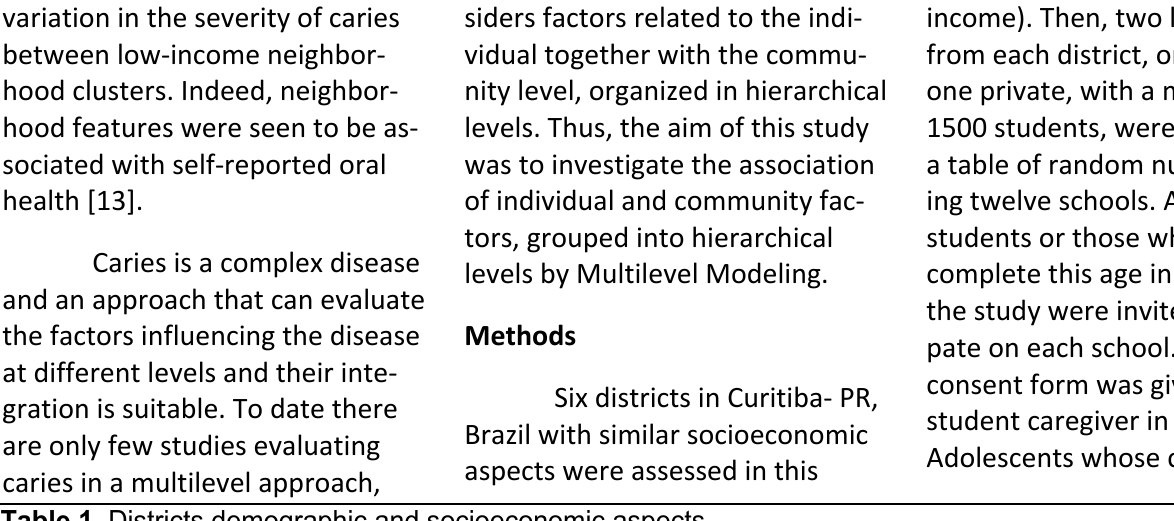
Table 1. Districts demographic and socioeconomic